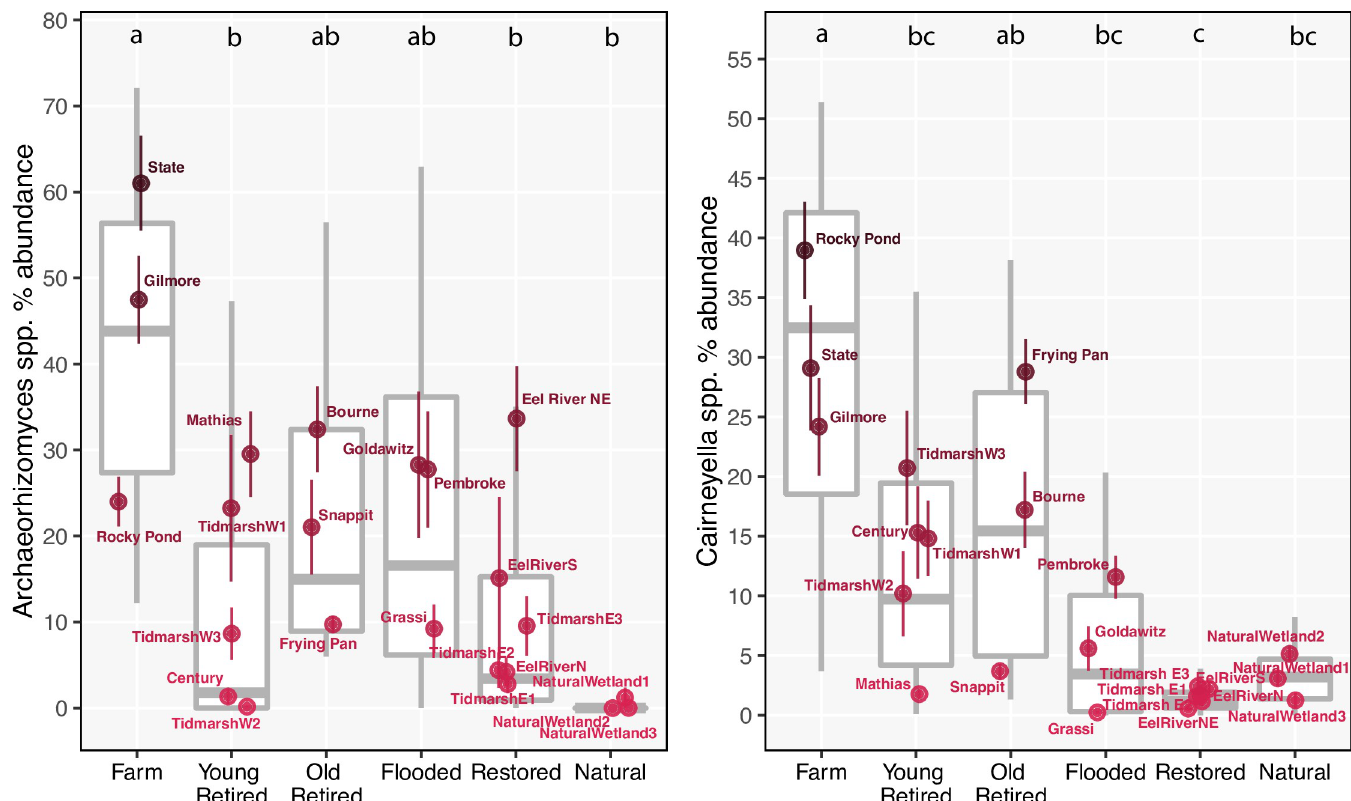
Fig 6. Relative dominance of two most common eukaryotic genera. The two most common eukaryotic genera were Archaeorhizomyces and Cairneyella , suspected mycorrhizal symbionts of the cranberry crop. Both genera had lower median within-sample dominance in young retired farms, old retired farms, flooded, restored, and natural sites than in cranberry farms. Points indicate mean abundance for each site and vertical lines are standard errors calculated from eight technical replicates. Grey box plots indicate the median and interquartile range of all soil samples within each treatment category.